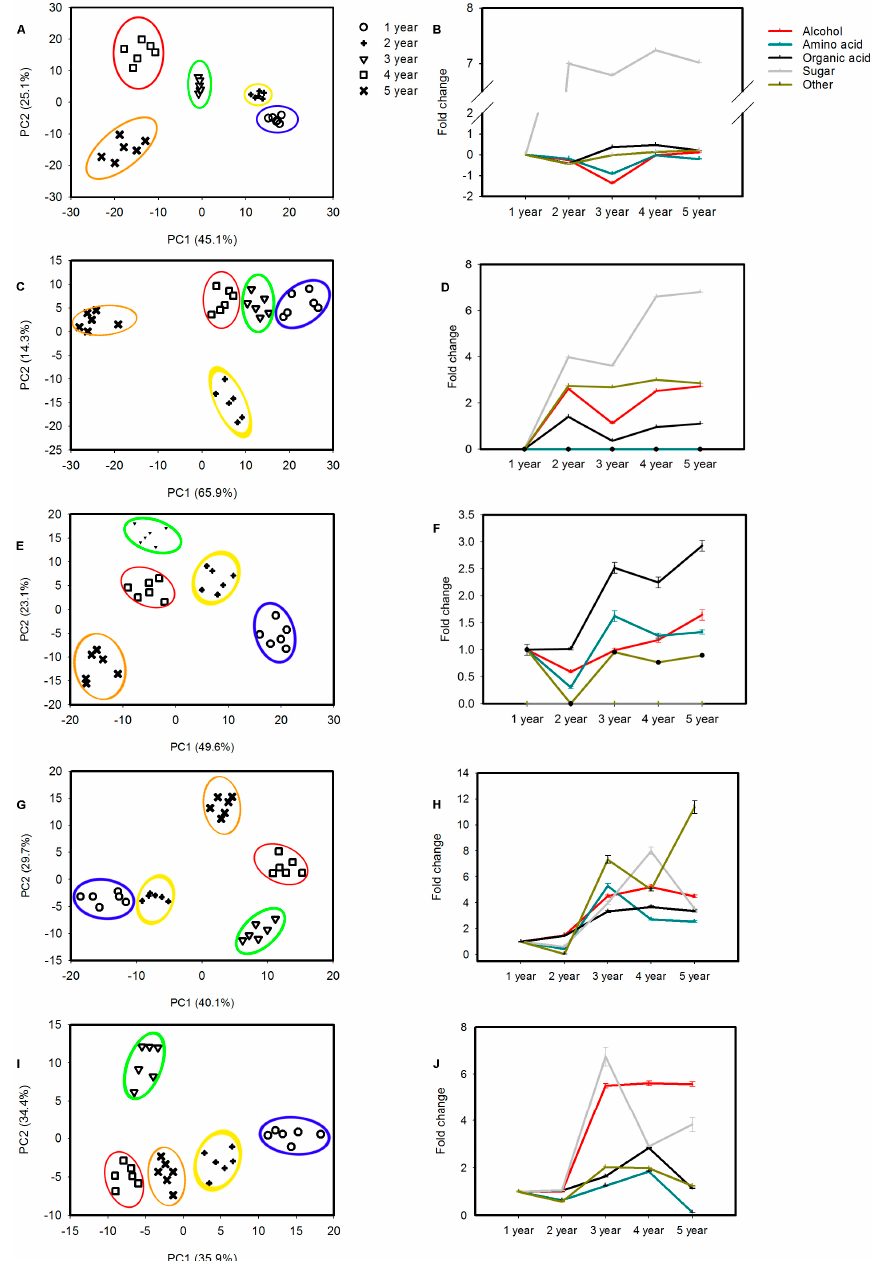
Figure 2. Metabolic analysis of tissues at five developmental stages. Ginseng samples of five developmental stages 1-, 2-, 3-, 4- and 5-year old were collected for metabolite analysis by GC-MS. ( A , C , E , G , I ) PLS-DA analysis of developing leaf, petiole, stem, lateral root and root from five stages, respectively; ( B , D , F , H , J ) Fold change of alcohol, amino acid, organic acid, sugar and other metabolites in leaf, petiole, stem, lateral root and root at five developmental stages. The data represent the mean ± standard error of the mean values for six biological replications. A supervised PLS-DA analysis, which could classify the observations into the group from giving the largest predicted indicator variable, with unit variance (UV) scaling (variables-subtracted